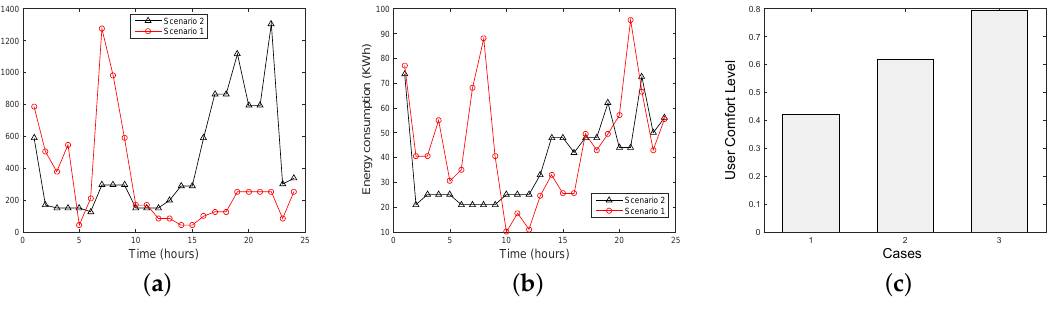
Figure 6. EMS: by using sensor networks (Scenario 2). ( a ) Cost profile (Scenario 2); ( b ) load profile (Scenario 2); ( c ) UCL when: Case 1: α , ζ = 0.3, 0.7; Case 2: α , ζ = 0.5, 0.5; Case 3: α , ζ = 0.7,